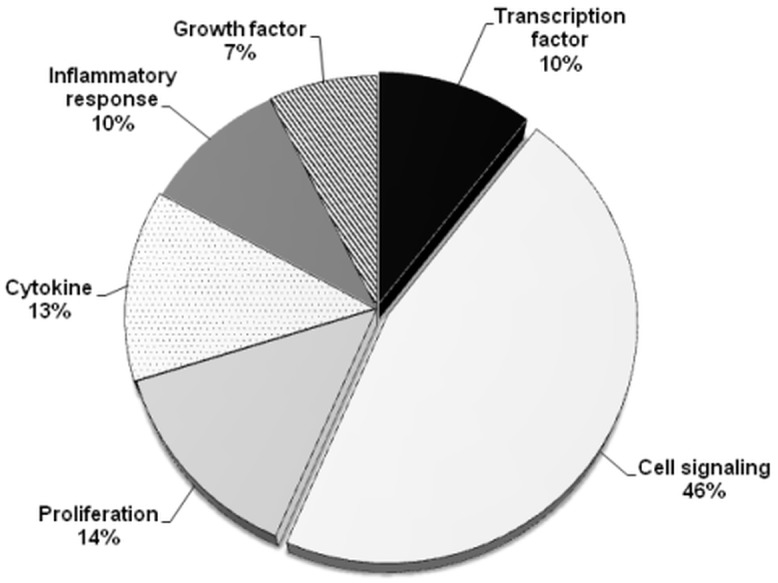
Effect of ZEA diet on global gene profile in spleen.Functional cluster analyses (%). Spleen responsive genes were categorised in 6 functional groups based on gene ontology available in the Entrez data base and using GeneSpring GX Version 12.6.1 software and Microsoft Excel.